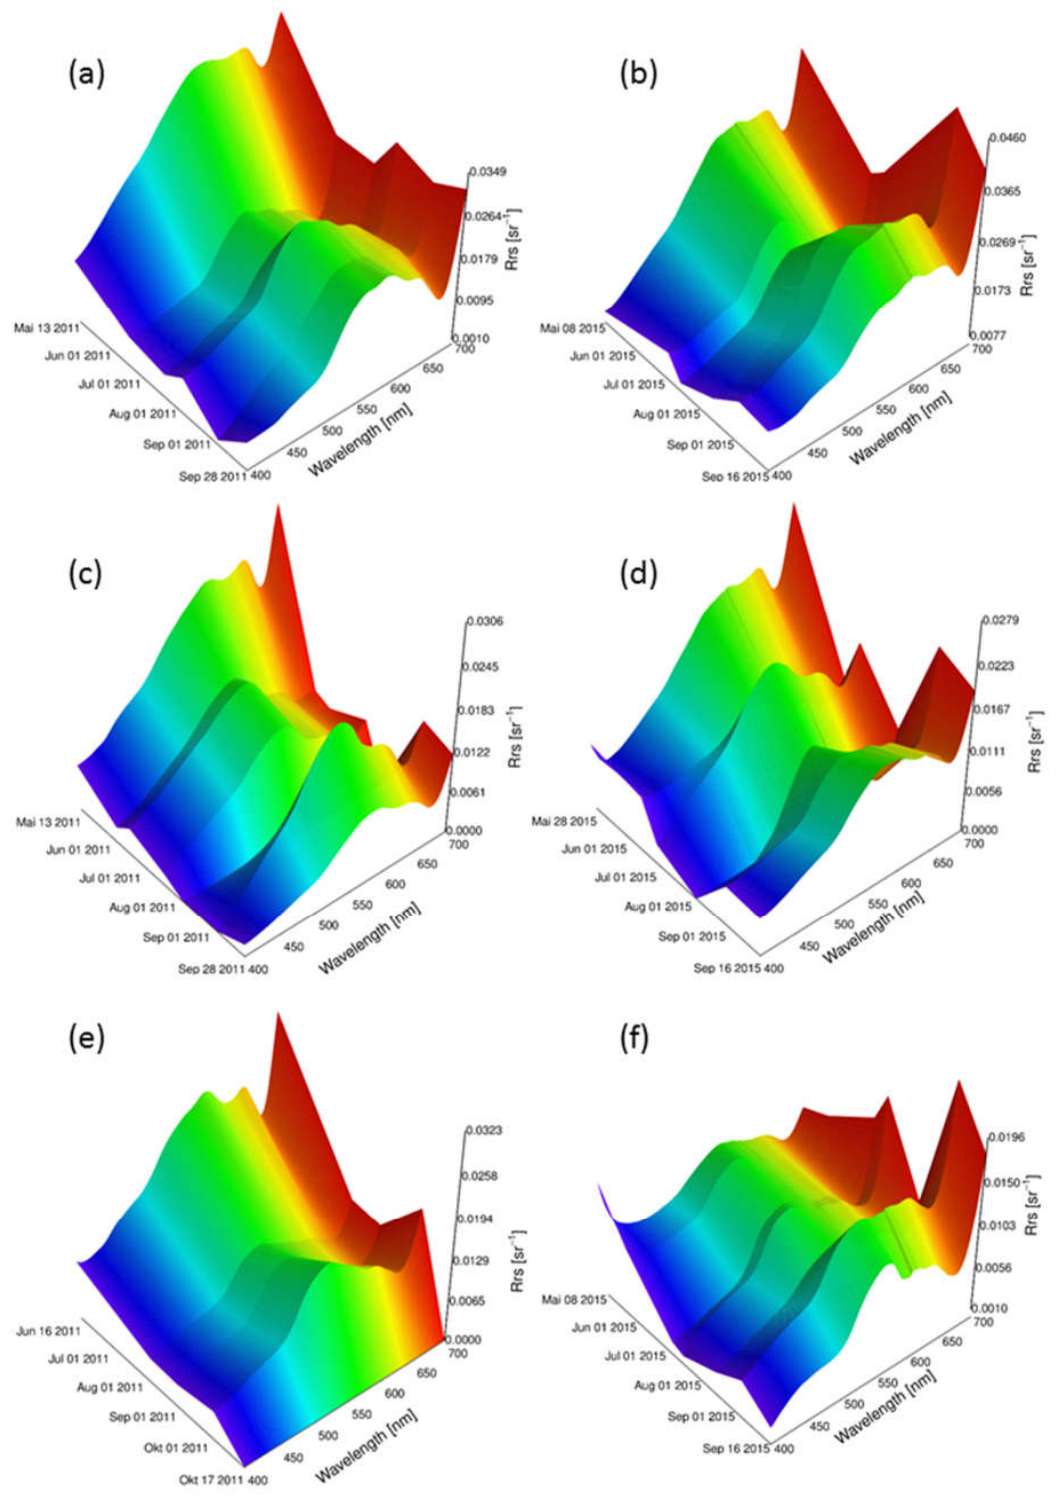
Figure 5. Reflectance models of three macrophyte species for 2011 and 2015. Chara spp. for sun zenith angle 35° in: ( a ) 2011; and ( b ) 2015; P. perfoliatus for sun zenith angle 27° in: ( c ) 2011; and ( d ) 2015; and E. nuttallii for sun zenith angle 31° in: ( e ) 2011; and ( f ) 2015.